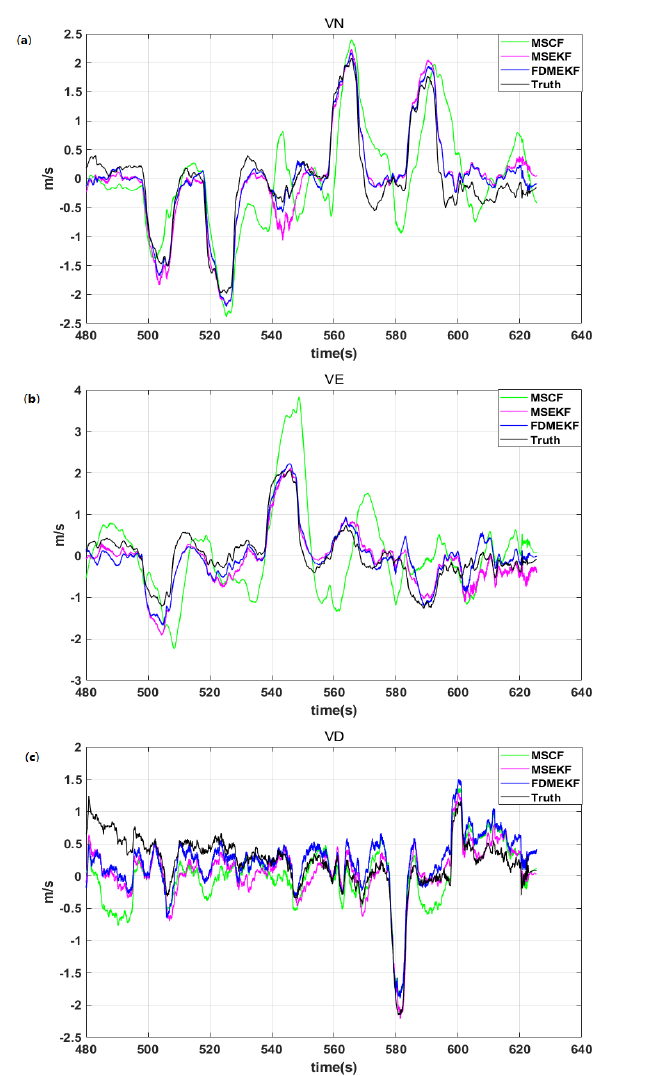
Figure 11. The velocity of the UAV in flight. ( a ) the north velocity of the UAV; ( b ) the east velocity of the UAV; ( c ) the down velocity of the UAV.